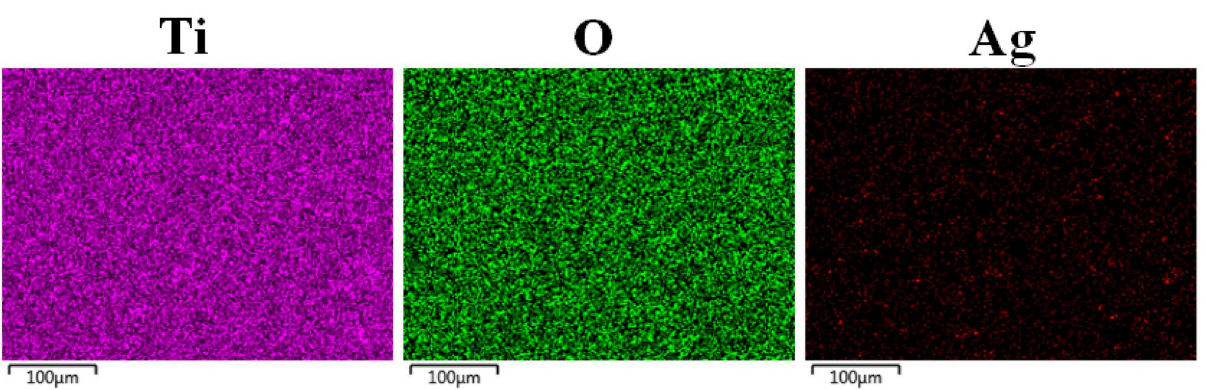
Figure 2. Elemental mapping images of AgNPs-deposited nanotube surfaces for 5